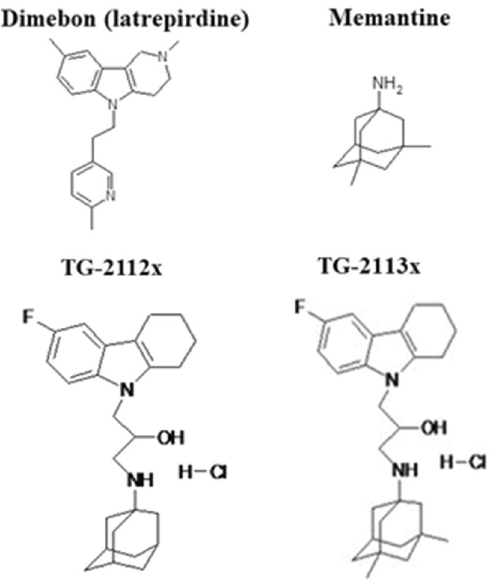
Figure 1. Structure of conjugates of derivatives of aminoadamantanes and ɣ -carbazoles, prototype